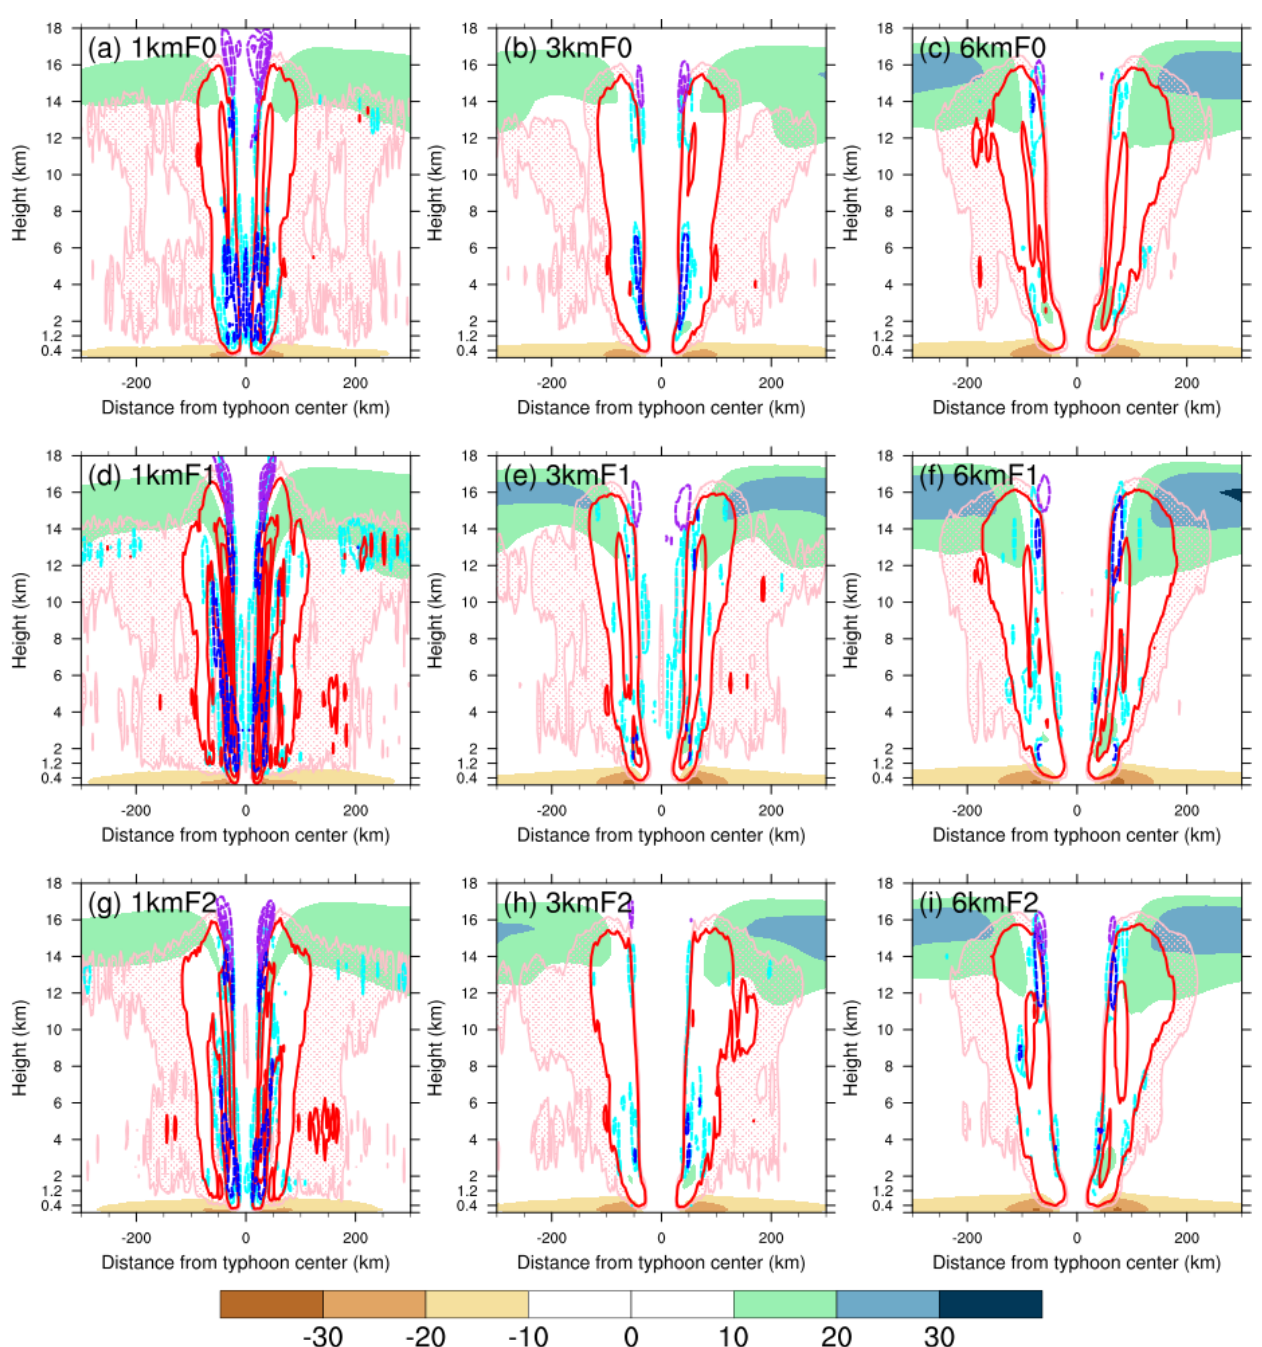
Figure 11. The same as Fig. 10 but for vertical velocity (contours; ms − 1 ) and radial wind (color shaded; ms − 1 ). Positive (upward) and negative (downward) velocities are indicated by red and blue contours, respectively, and are plotted every 1ms − 1 starting from wind speeds of 0.5ms − 1 . In addition, pink hatched areas denote an upward velocity of 0.3–0.5ms − 1 ; cyan contours denote a downward velocity of − 0 . 3ms − 1